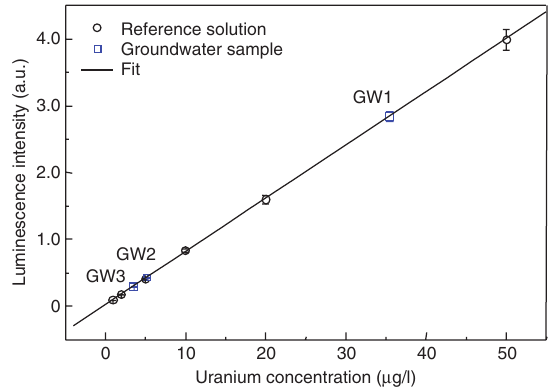
SO and 0.074 m H SO ] and the 2 4 2 4 S O , respectively. 2 2 8